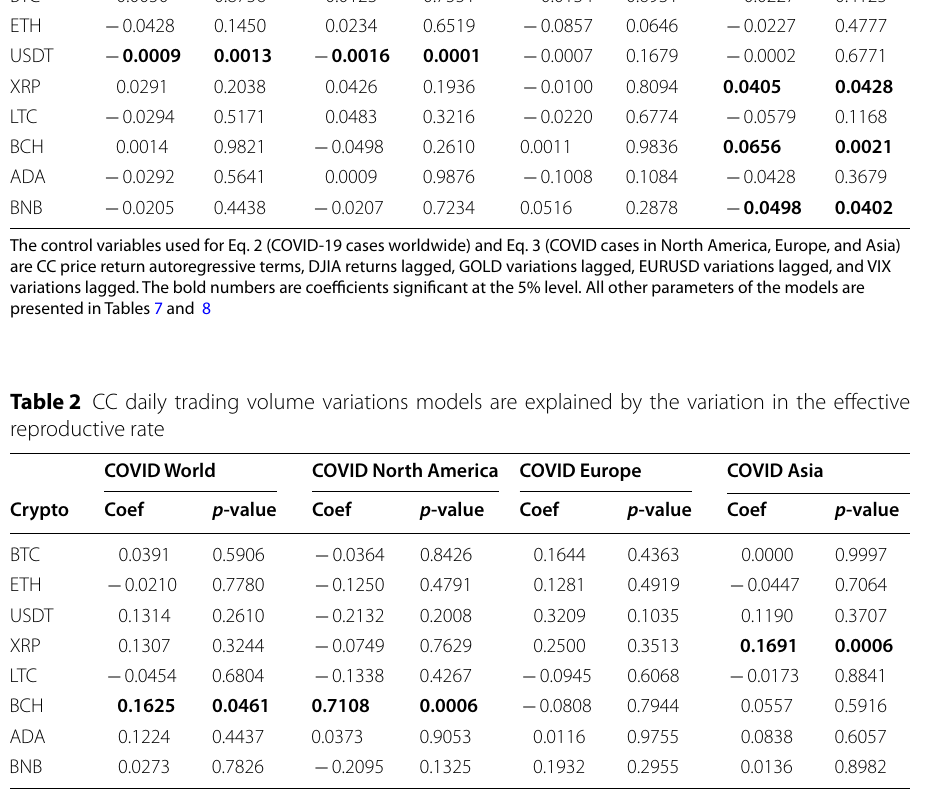
Table 1 CC return price models are explained by the variation in the effective reproductive rate